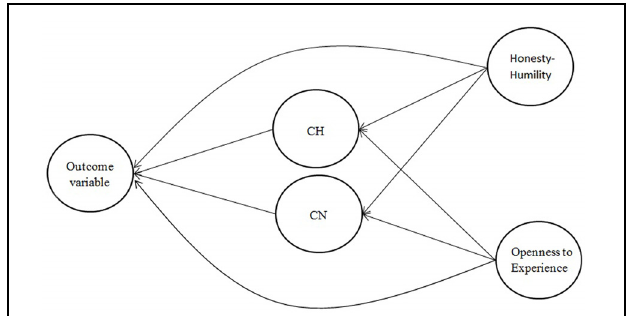
FIGURE 2 | A Graphical Depiction of the Mediation Analysis. CH, Connectedness to Humanity; CN, Connectedness to Nature.